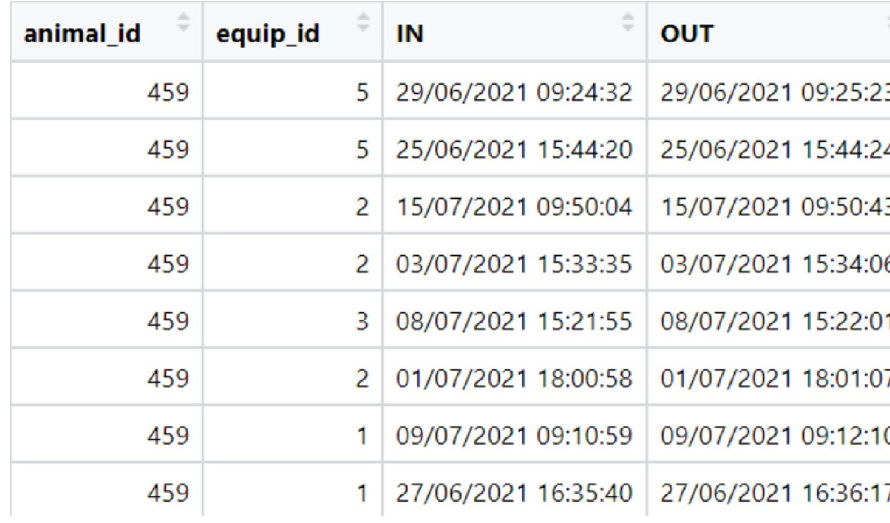
Fig 2. A sample of the input database with data from the electronic feeding system of Nellore cattle used in the replacement() function.